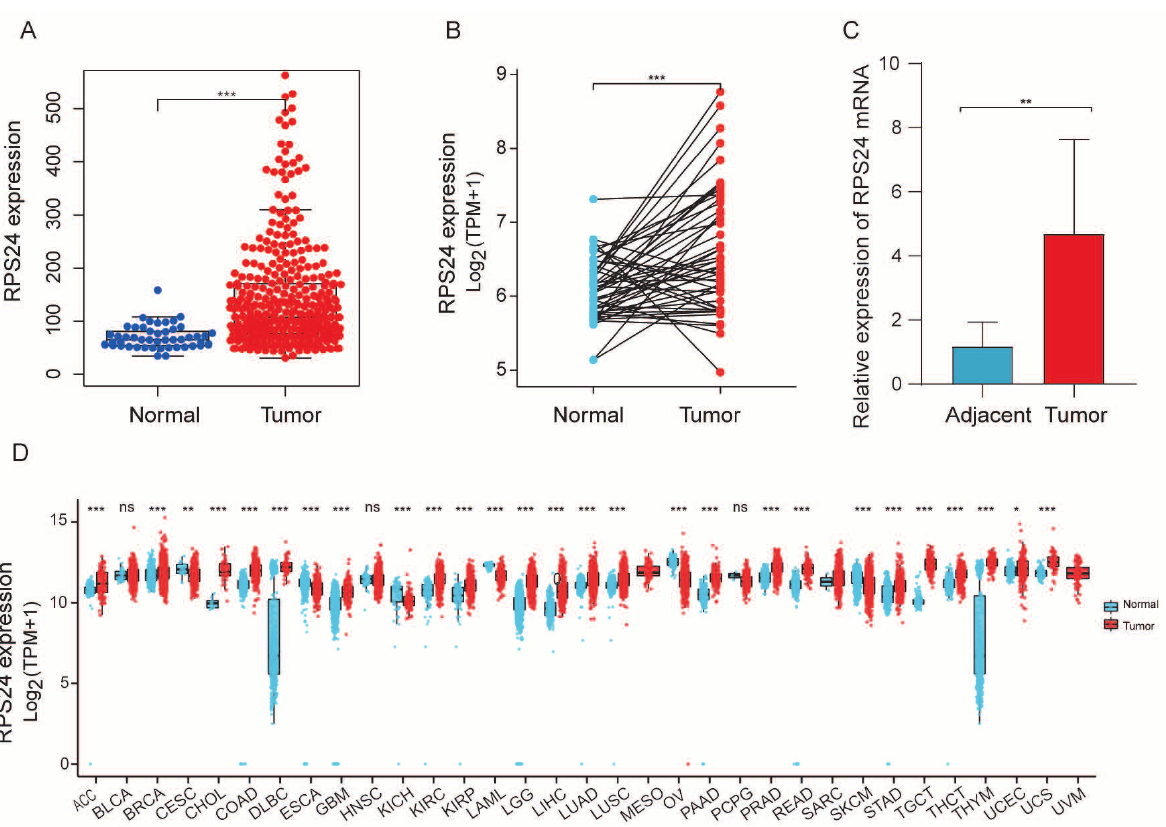
Figure 1. RPS24 is highly expressed in HCC. ( A , B ) Detection of RPS24 mRNA in cancerous samples with unpaired ( A ) and paired normal tissues using the TCGA-LIHC dataset ( B ). ( C ) In 20 paired samples of HCC patients, the RPS24 mRNA levels were tested using qRT-PCR (cohort 1). ( D ) The expression of RPS24 mRNA in pan-cancers using the TCGA tumor database. ns p ≥ 0.05; * p < 0.05; ** p < 0.01; *** p < 0.001.